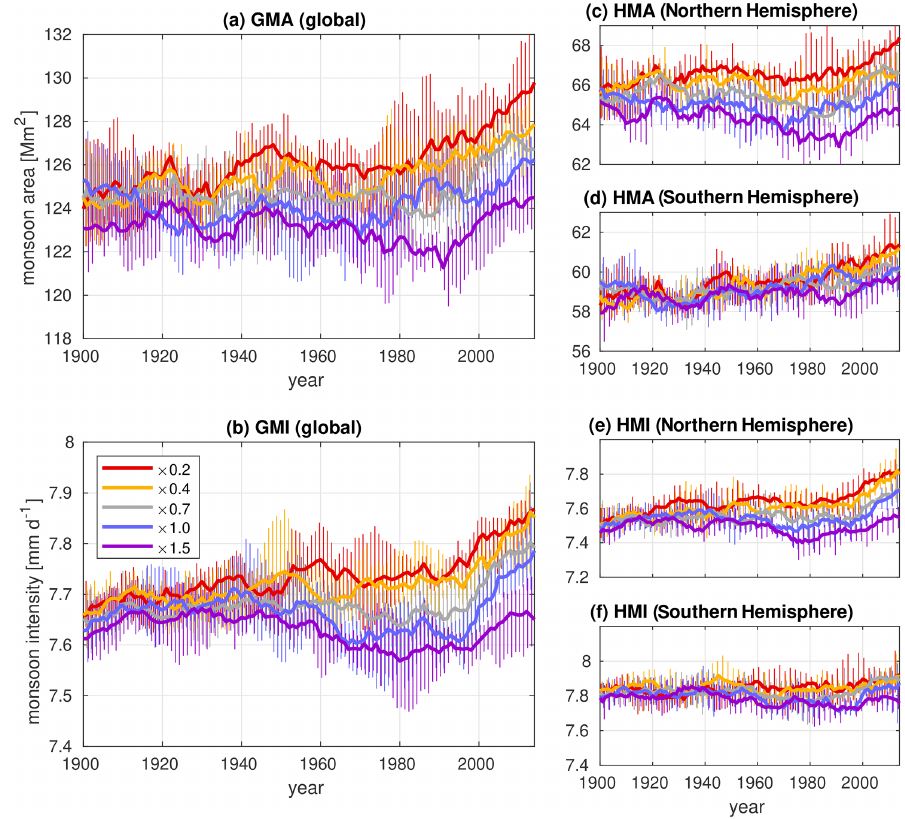
Figure 4. Time series of (a) global monsoon area (GMA) and (b) global monsoon intensity (GMI) for each experiment. (c–f) show the hemispheric equivalents (HMA and HMI) for NH and SH. The ensemble mean is shown, with an 11-year running mean applied. The vertical error bars indicate the range across the five members. GMA is in square megametres, where 1Mm 2 = 1 × 10 6 km 2 .